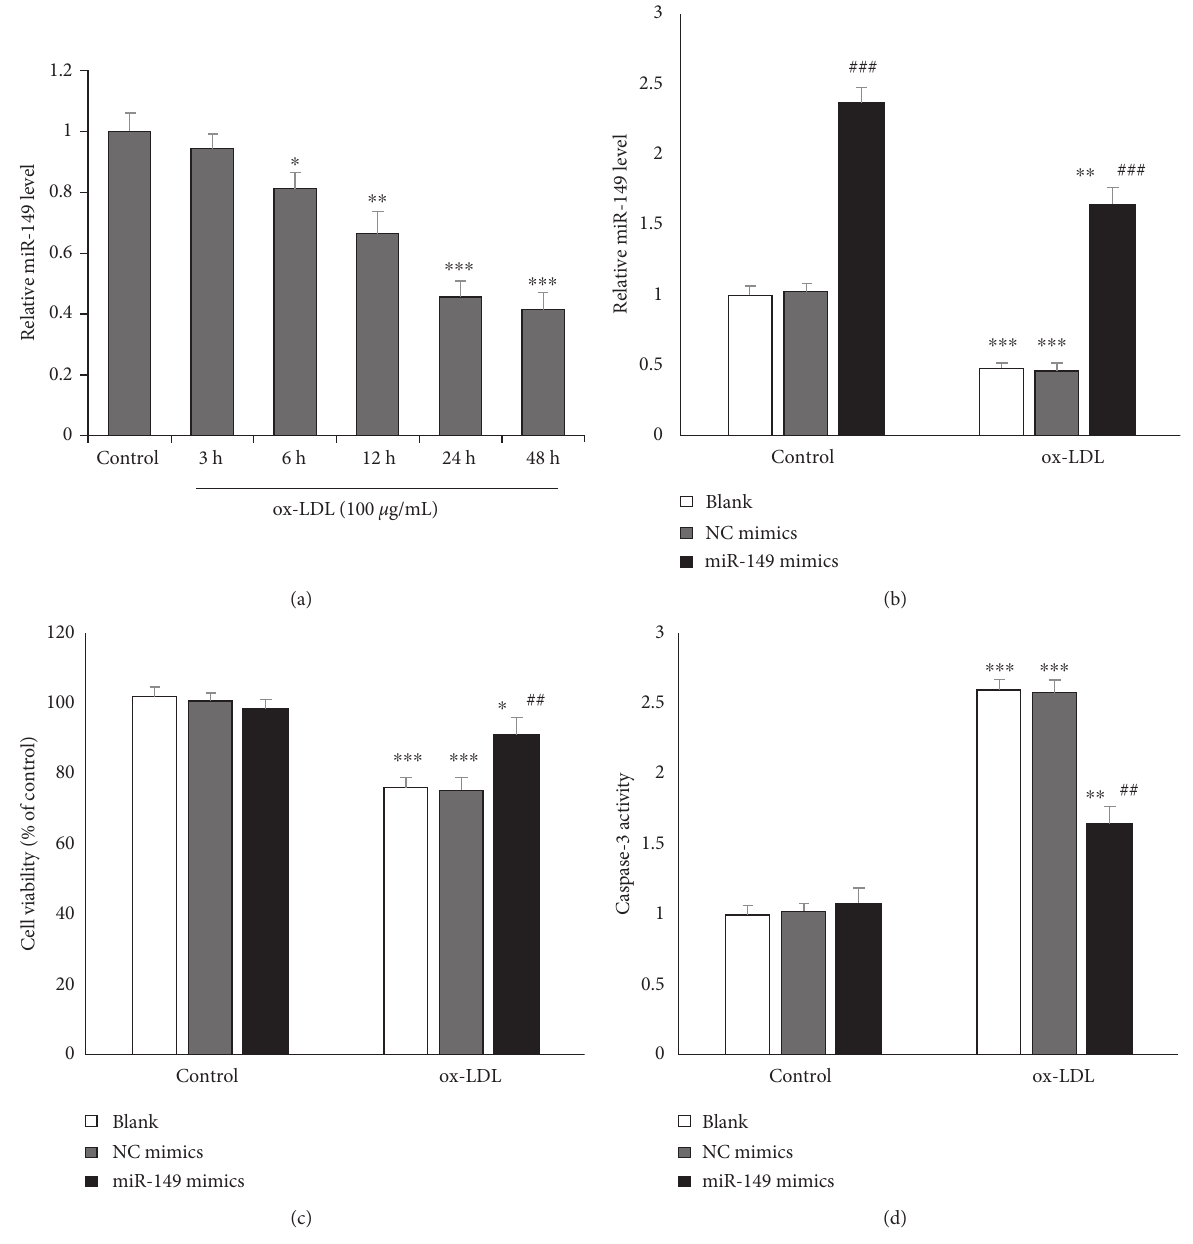
Figure 1: miR-149 mimics protect against HUVECs injury. (a) miR-49 level was reduced after ox-LDL incubation. (b) miR-49 level was increased after transfecting with miR-149 mimics for 24h in HUVECs. (c) miR-149 mimics transfection increased cell viability. (d) miR-149 mimics transfection reduced caspase-3 activity. ∗ P < 0 . 05, ∗∗ P < 0 . 01, and ∗∗∗ P < 0 . 001 vs. control group; ## P < 0 . 01 vs. ox-LDL